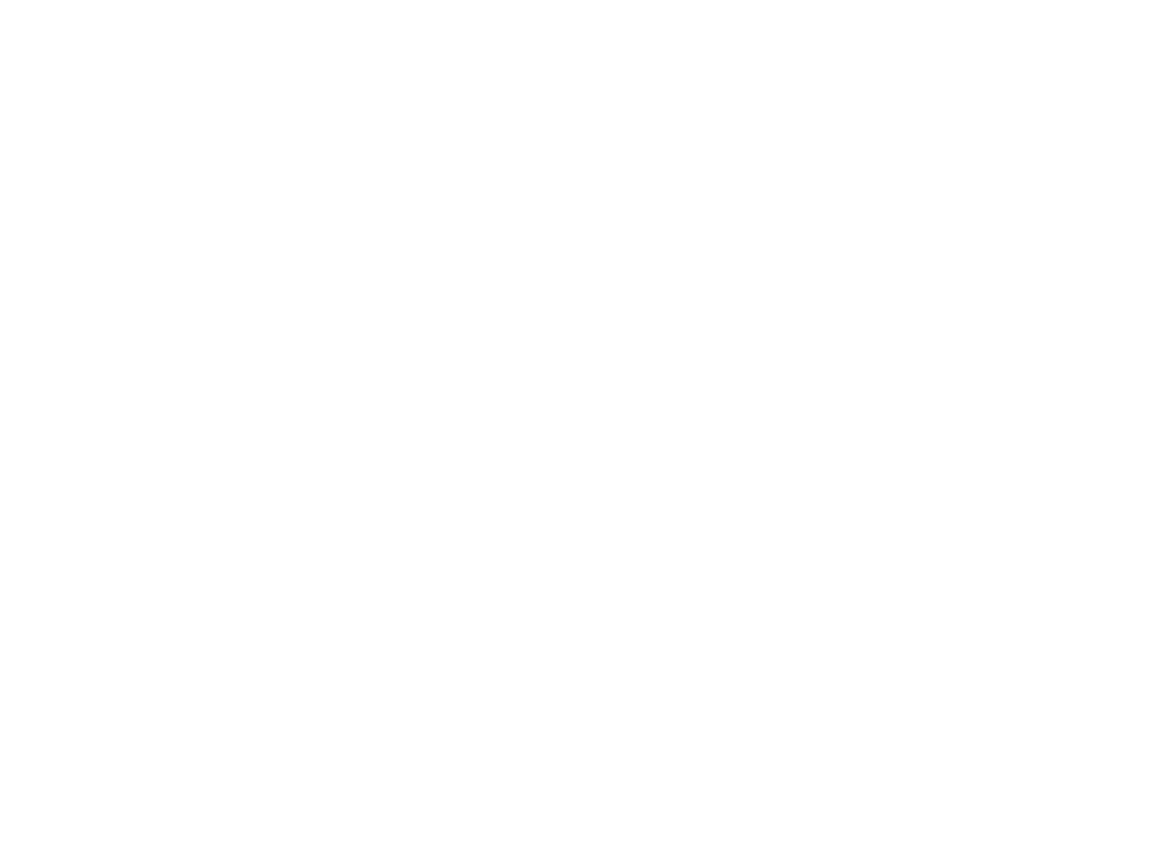
Figure 21. Example